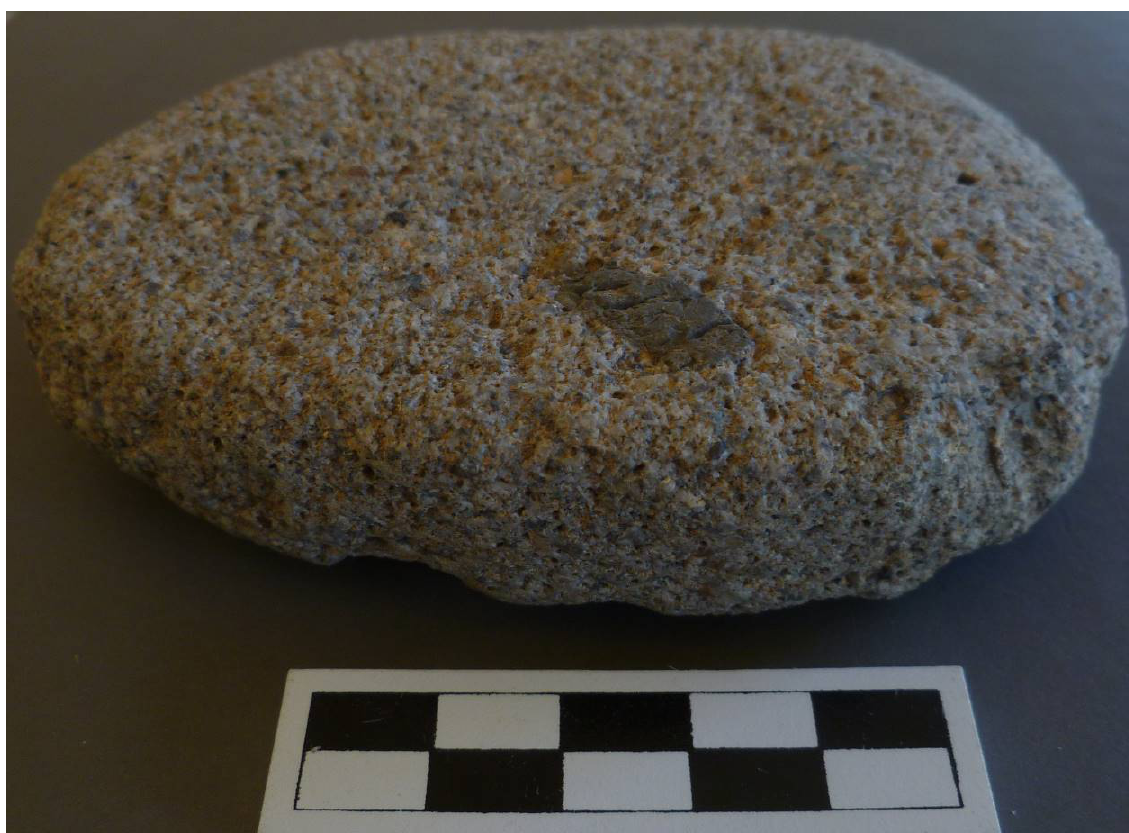
Figure 7. Typical hand stone from Burgasny Enger (Ikh-28). Profile view of artefact shown in Figure 6.